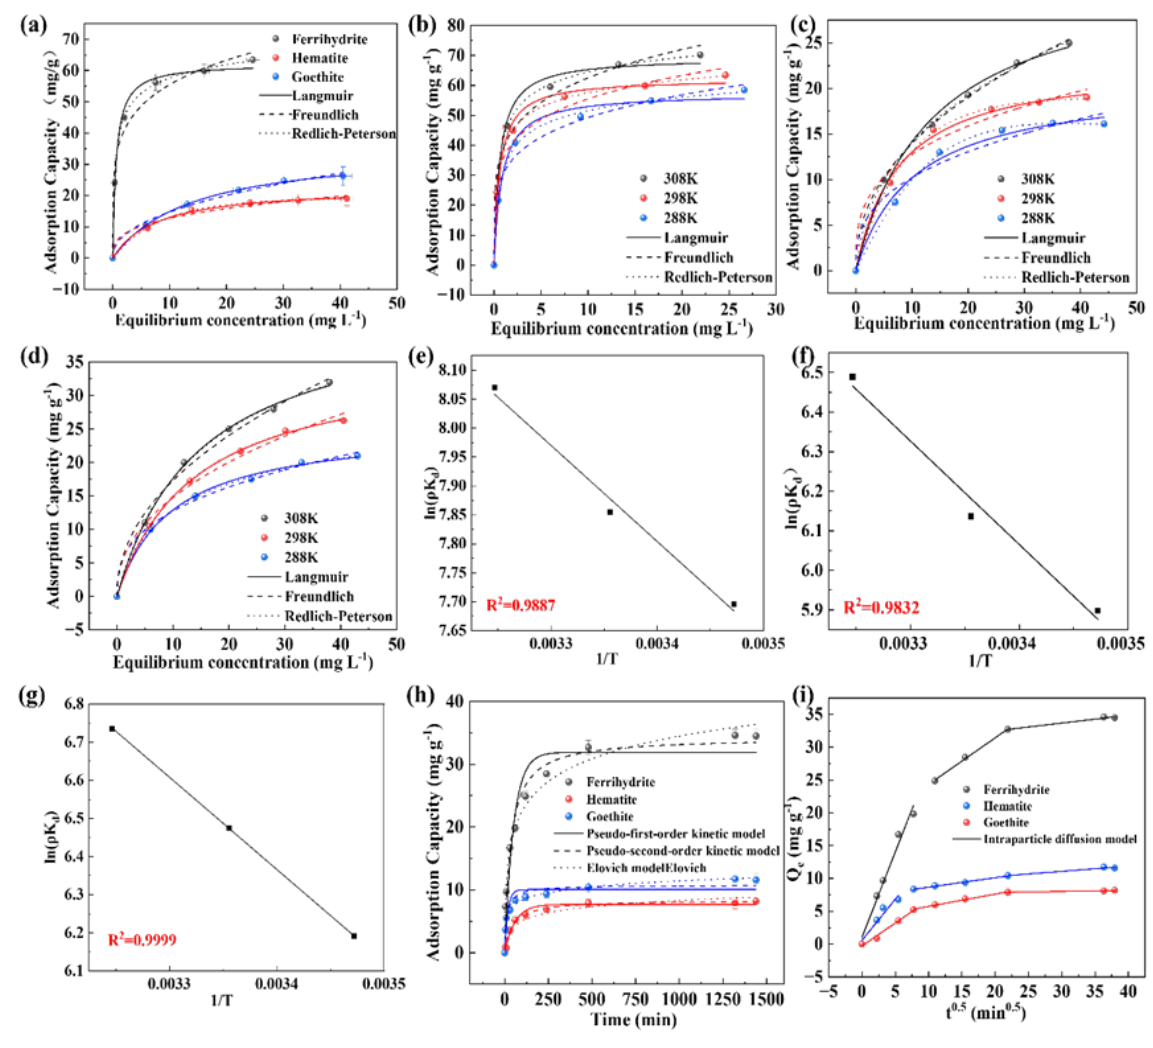
Figure 3. ( a ) Isothermal adsorption model of iron minerals, isothermal adsorption models of ( b ) ferrihydrite, ( c ) goethite, and ( d ) hematite at different temperatures. Van ‘t Hoff curve of adsorption of PAA by ( e ) ferrihydrite, ( f ) goethite, and ( g ) hematite. ( h ) Kinetic model of iron minerals. ( i ) Intragranular diffusion model. Table 1. Isothermal adsorption model fitting results of PAA adsorption by iron minerals. Adsorbent